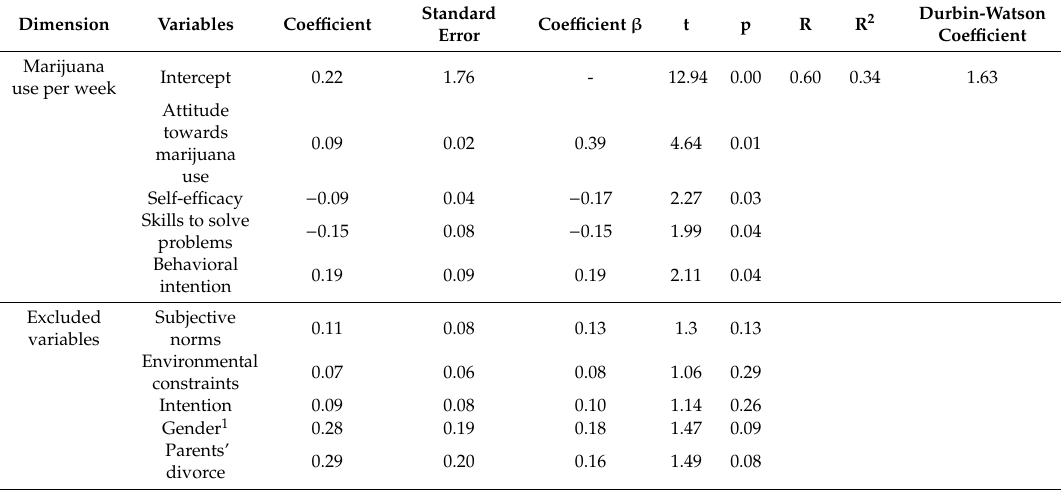
Dimension Variables Coe ffi